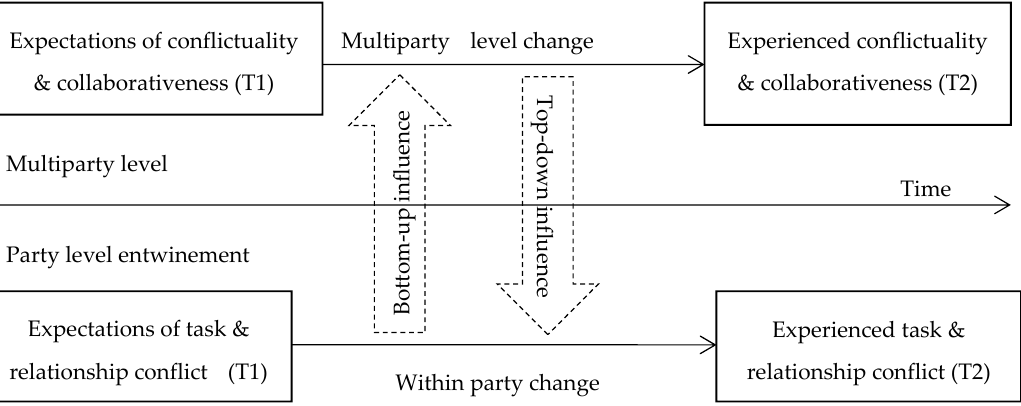
Figure 1. Bottom-up and top-down influences in multiparty systems. Note: T1 = time 1 (expectations before the interaction starts), T2 = time 2 (experienced dynamics at the party and multiparty level).